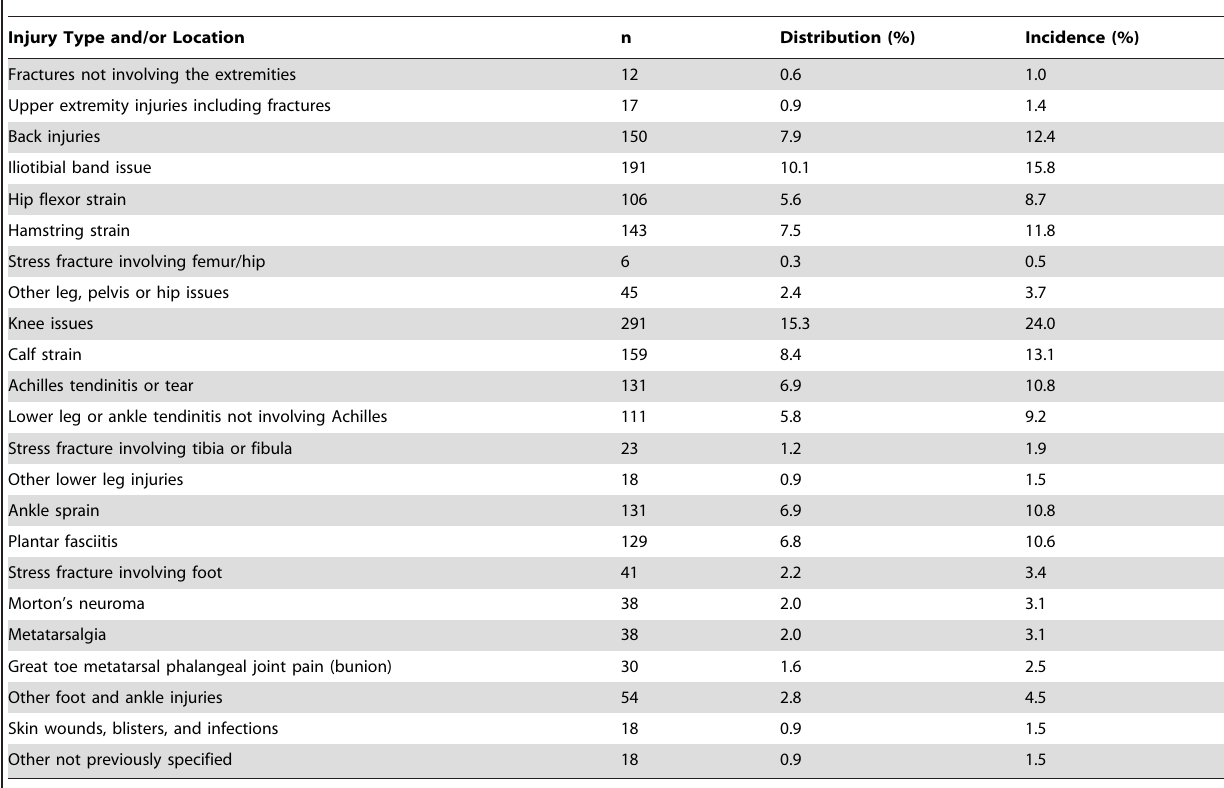
Table 5. Number, distribution, and incidence of various exercise-related injuries in the prior 12 months among 1,212 active ultramarathon